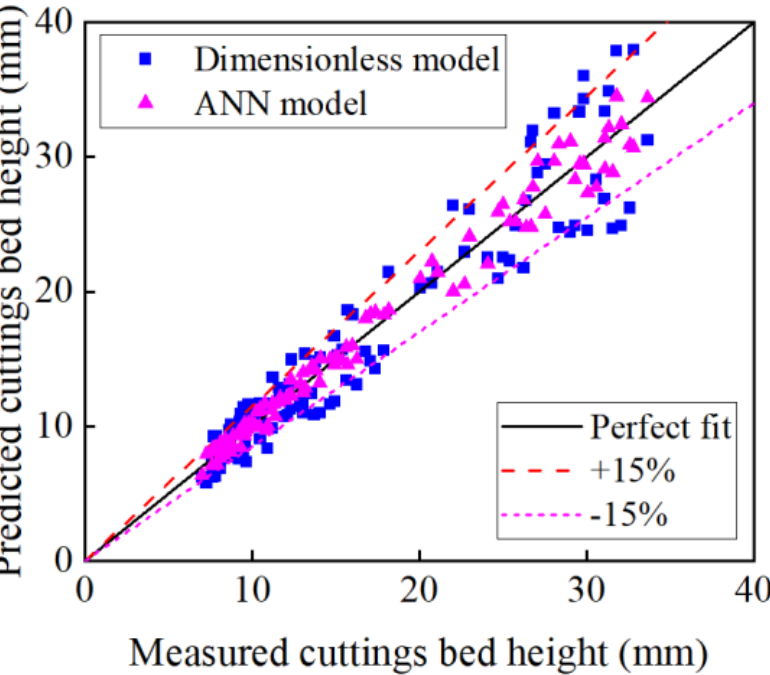
Figure 10. Comparison of predicted results of ANN and dimensionless cuttings bed height